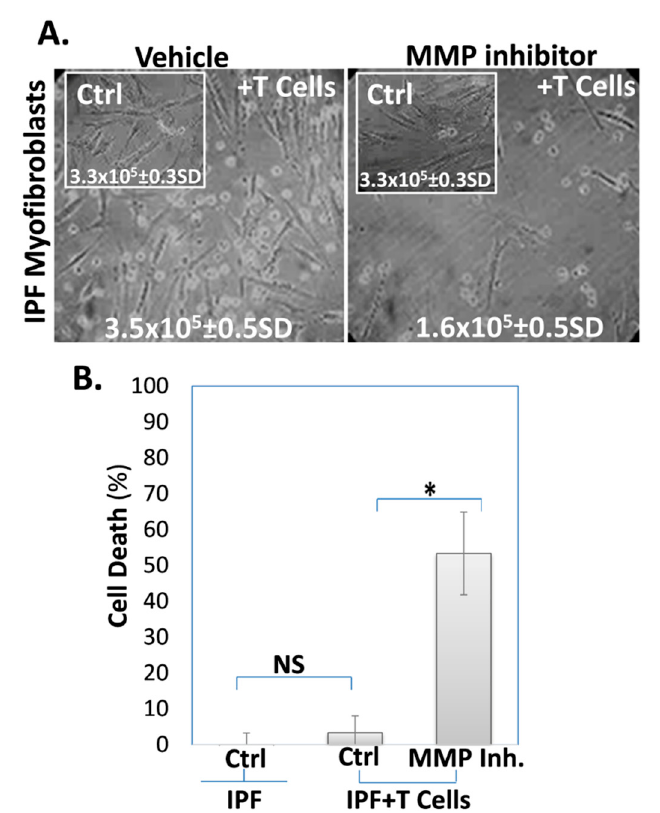
Figure 2. The MMP inhibitor (batimastat) decreases IPF-lung myofibroblast’ resistance to T cell-induced cell death. (A) Light microscope images with trypan blue exclusion (inserted numbers); and ( B ) Graphical presentation of the cell death percentage defined by trypan blue exclusion.